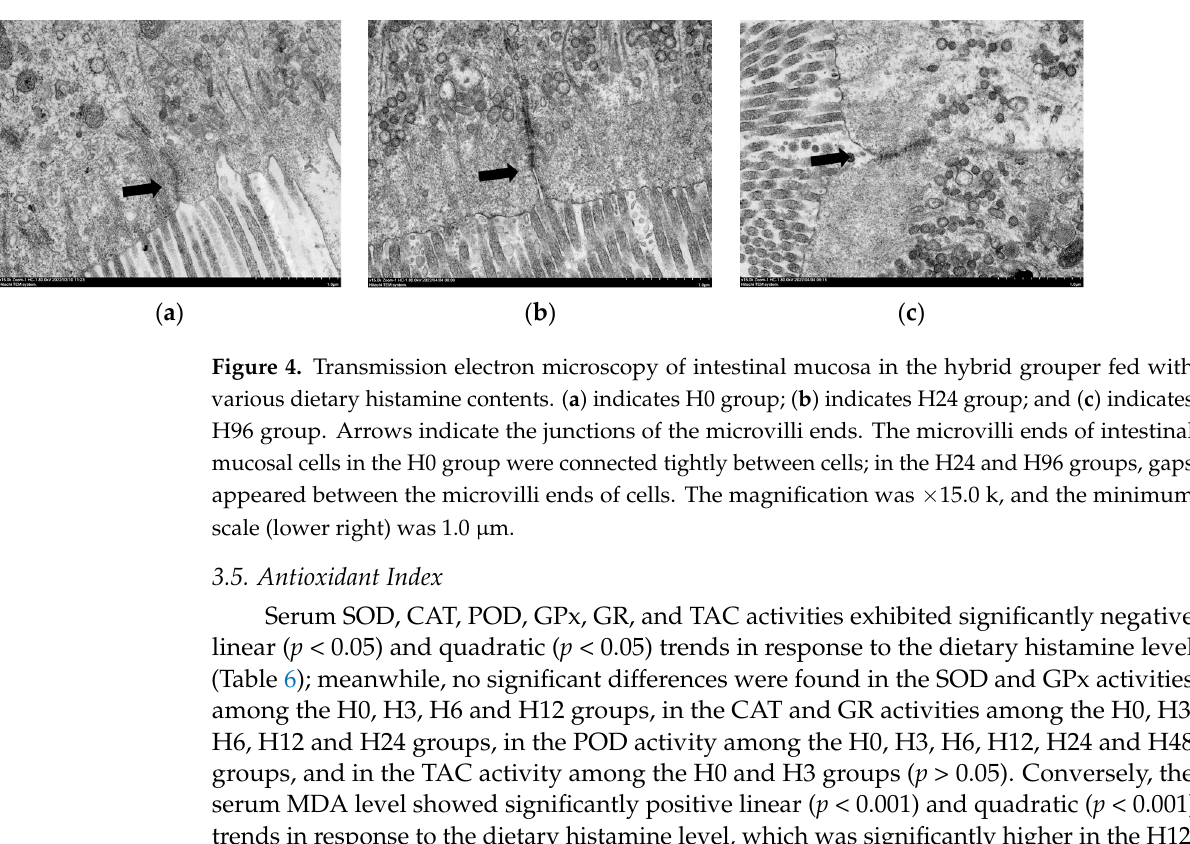
Table 6. Effect of dietary histamine content on the antioxidant-related index in the serum of the hybrid grouper.